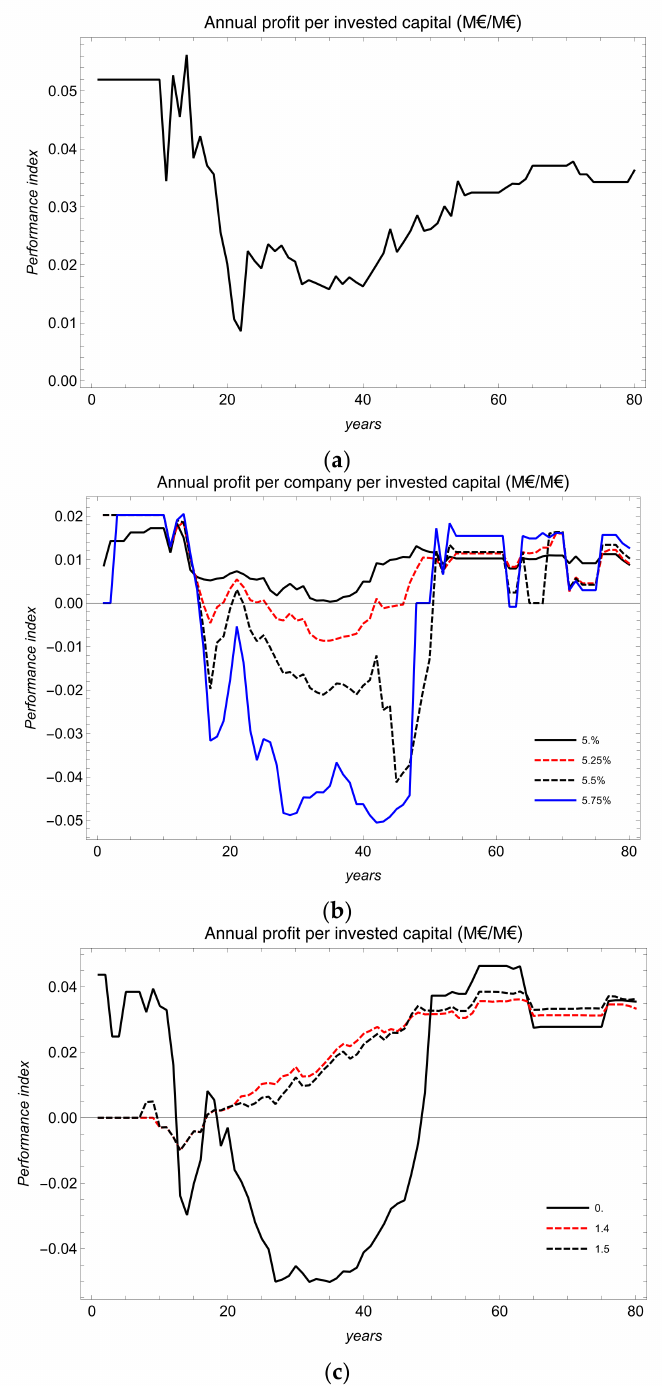
Figure 10. Individual agents’ economic performance in the ( a ) homogeneous case, ( b ) HHR case, and ( c ) HF case. In the homogeneous case, the index stays positive during the whole model run, while in the two heterogeneous cases, the index varies among agents due to their different invest- ment